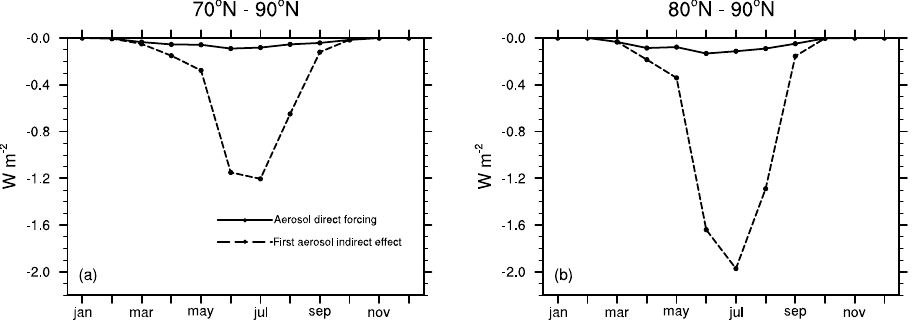
Fig. 14. Comparison of the modeled TOA aerosol direct radiative forcing and the first aerosol indirect effect for natural aerosols derived from the difference between the P2 and P1 simulations. Averages are taken using all grid points for the final five years of the model integrations.